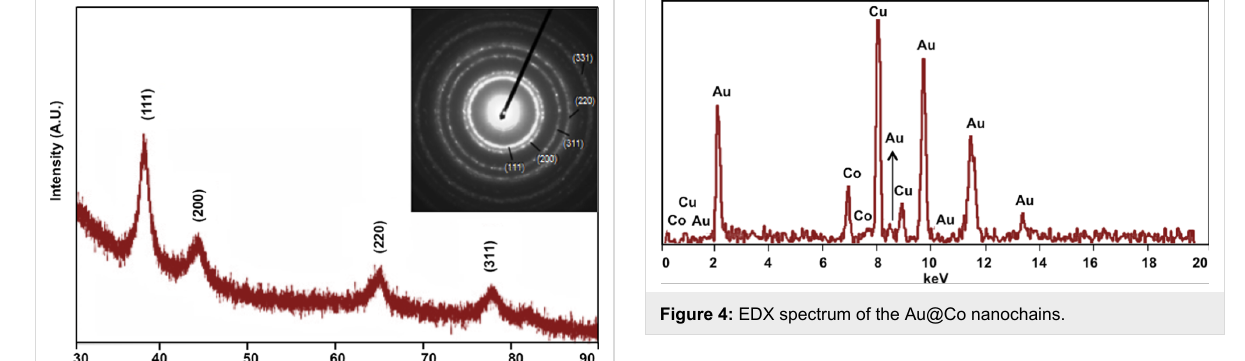
2 θ = 38.34°, 46.36°, 65.24° and 77.11°, which correspond, re- spectively, to the (111), (200), (220), and (311) crystallo- graphic planes of the face-centered cubic (fcc) structure of gold.